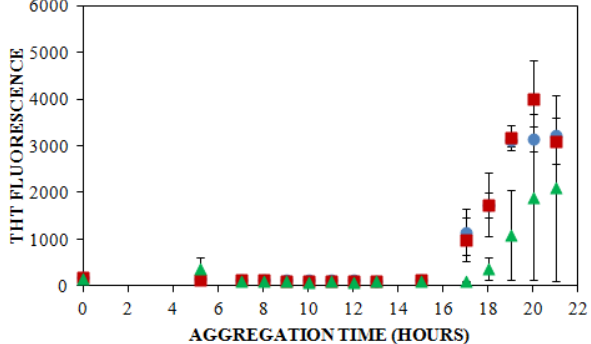
Figure 3. Effect of solution ionic strength on the formation of insulin aggregates detected by ThT binding. Insulin was diluted to 0.2 mg/mL in 40 mM Tris (pH 8.0) containing 100 mM (  ), 150 mM (  ), or 250 mM (  ) NaCl. Aggregation was induced at 25 ° C by continuous agitation (185 rpm) and monitored via ThT fluorescence by periodic dilution into 10 µM ThT. Error bars represent SE. Results are representative of two independent